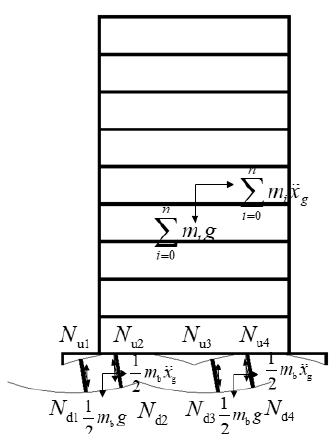
Figure 7. Force sketch of the isolation system equipped with SLDTFPB.